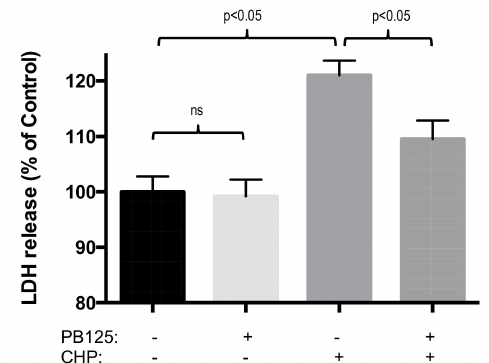
Figure 5. PB125 prevented oxidative stress-induced cell injury. Cellular injury (release of LDH into the culture media) was not observed in HepG2 cells treated overnight with 5 µ g / mL PB125 compared to vehicle control blank. In HepG2 cells cultured for 18h with 5 µ g / mL PB125 or vehicle control, from which the culture media was removed and replaced and the cells were challenged with an oxidative stress by treatment with 25 µ M cumene hydroperoxide (CHP) or untreated control for 6 h, cell injury (release of LDH) was caused by cumene hydroperoxide treatment but this injury was partially attenuated ( p < 0.05) by PB125